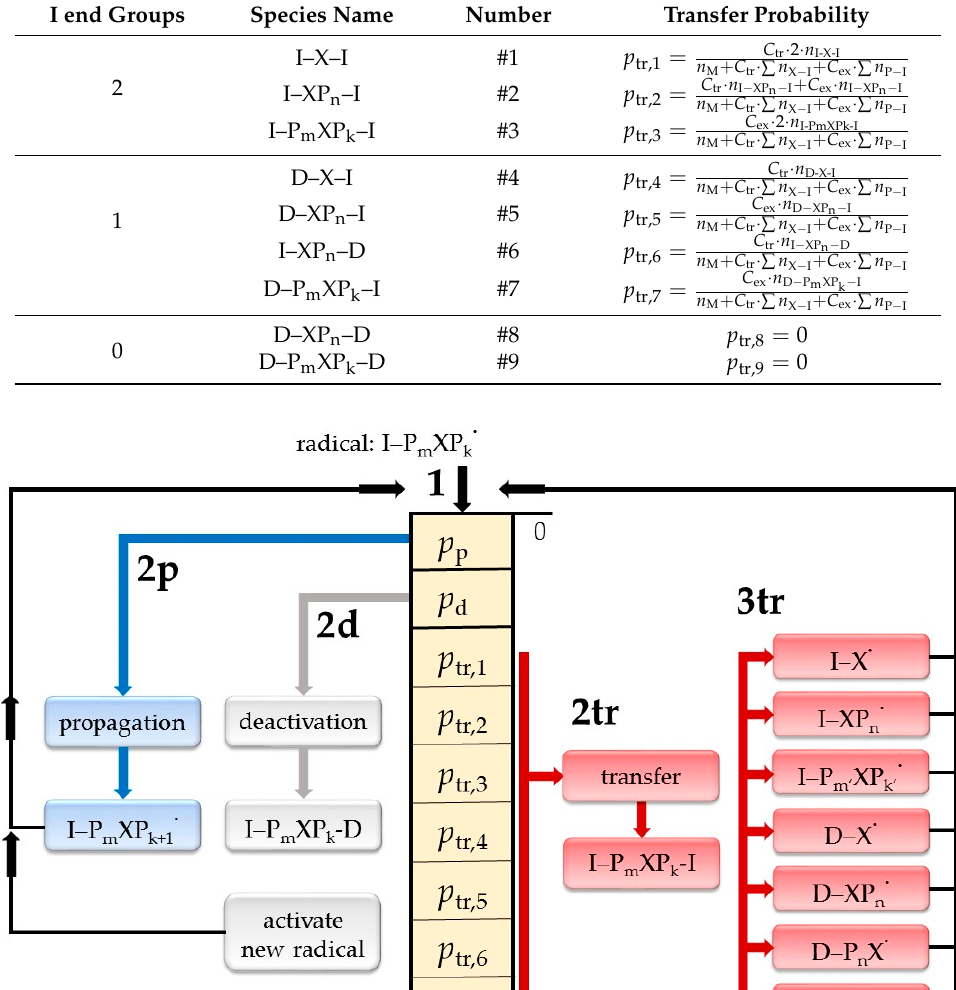
Table 2. Species accounted for in the kMC model. X: C 4 F 8 ; P n , P m and P k refer to polymeric chains of chain length n, m and k, respectively. D indicates irreversibly deactivated chain